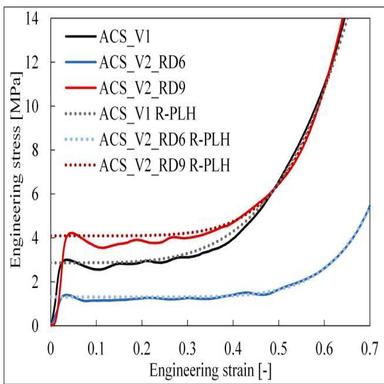
Average Q–S stress–strain relationships of ASC with R–PLH constitutive model predictions.